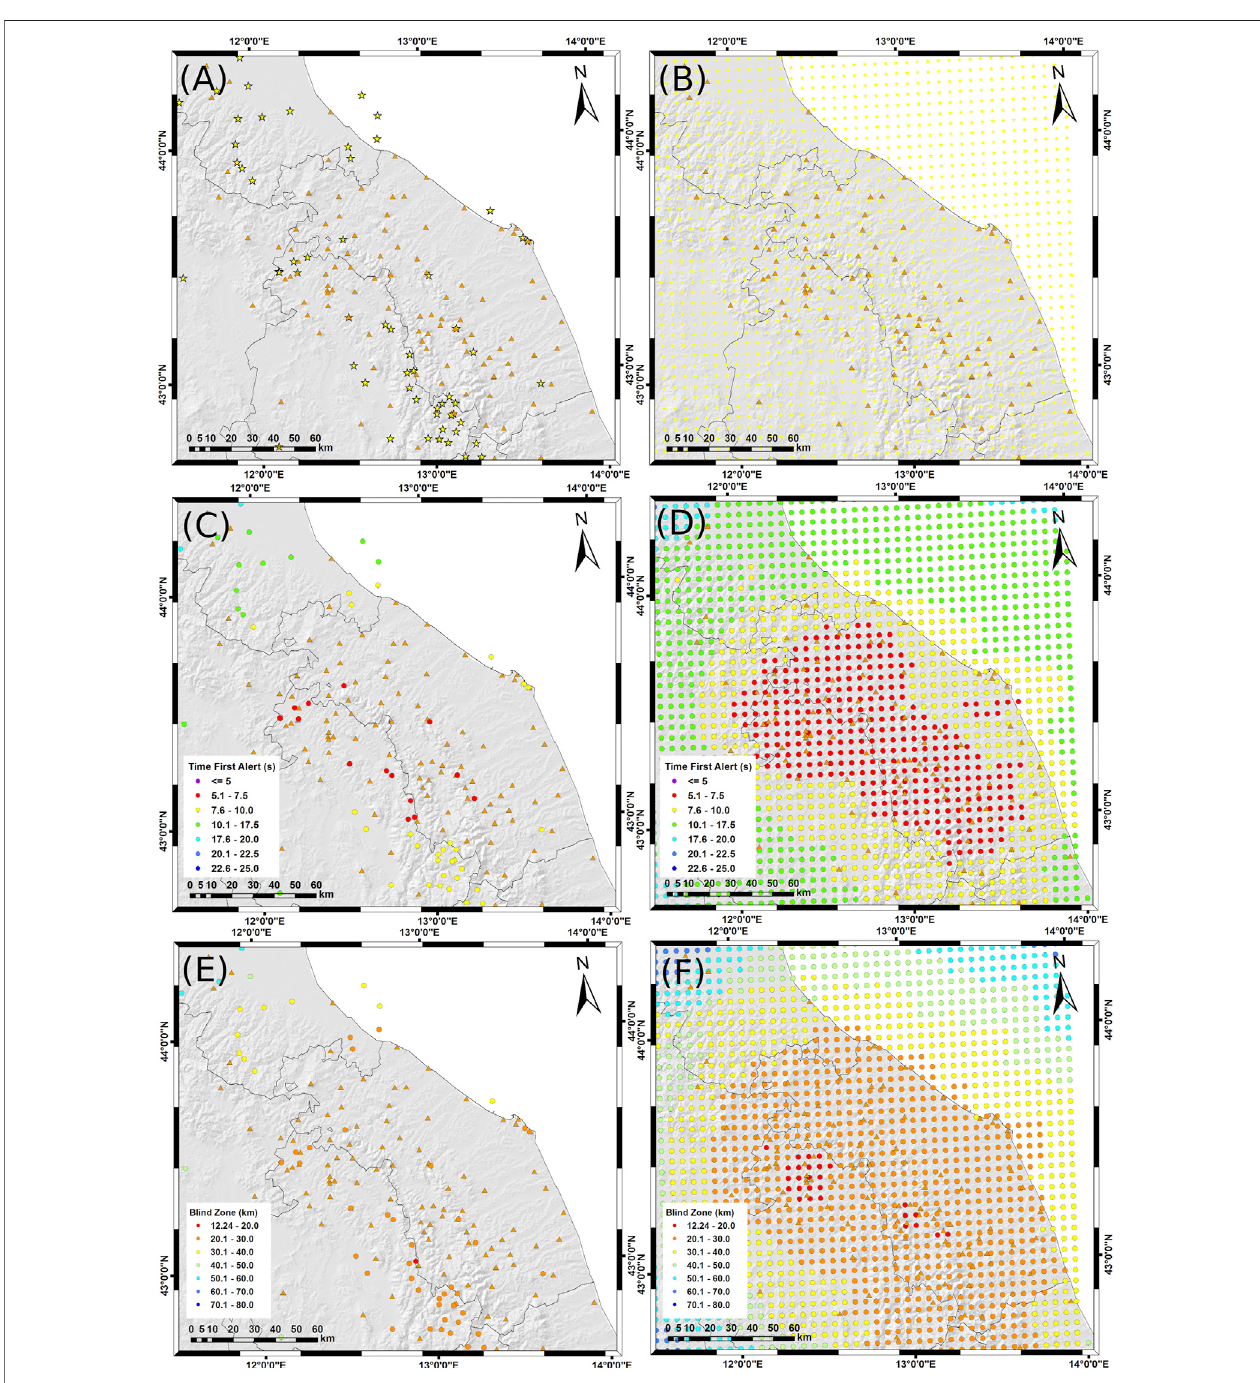
FIGURE 6 | TFA and BZ mapping. (A) : historical events from CPTI15 v3.0 Mw ≥ 5.5 from1269 to 2017 AD, depth 10 km before 1997. (B) : virtual grid of sources distant of 5 km and depth of 10 km. (C) : mapping of TFA with historical events. (D) : mapping of TFA with virtual grid. (E) : mapping of BZ with historical events. (F) : mapping of BZ with virtual